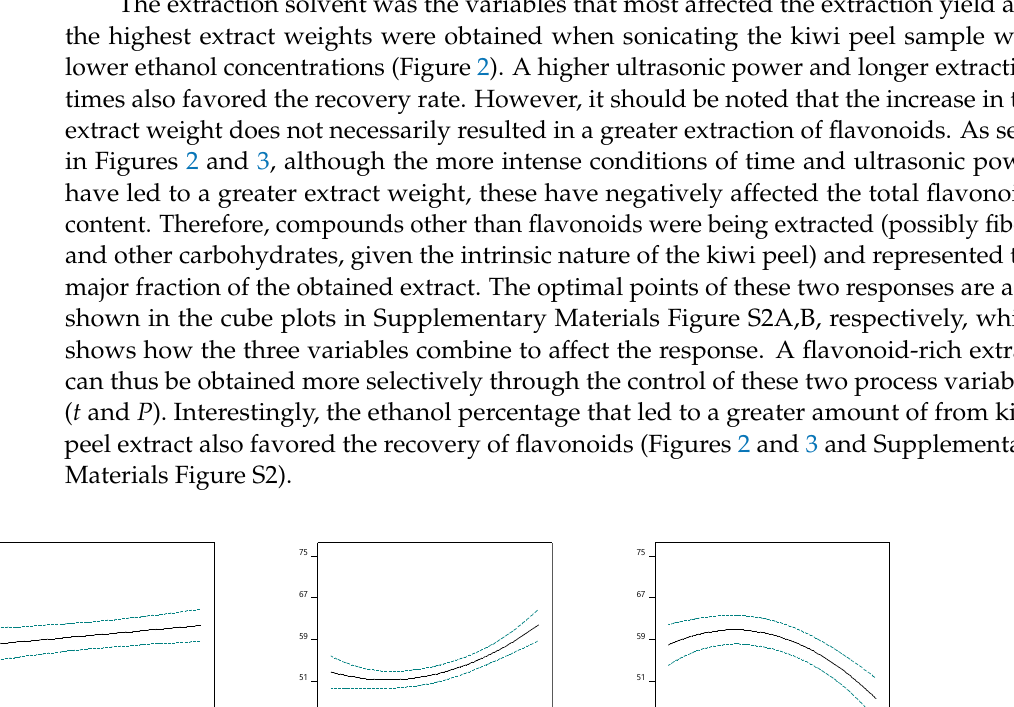
Figure 3. 2D response graphs for the effects of the independent variables on the total content of flavonoids ( Y 6 ) and ex- traction yield ( Y 1 ) obtained from kiwi peel. In each graph, the excluded variables were fixed at their optimal value.